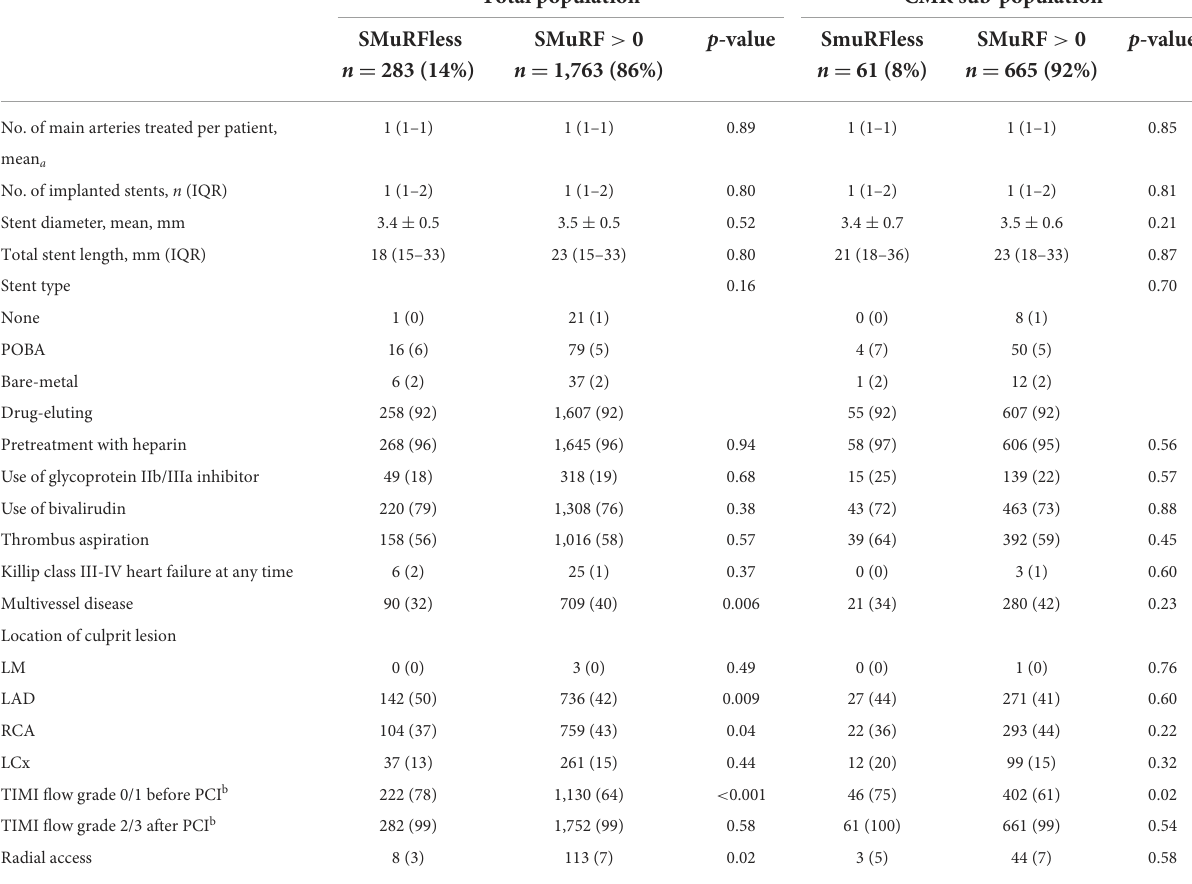
TABLE 2 Procedural data and medication given at discharge, total DANAMI-3 and CMR